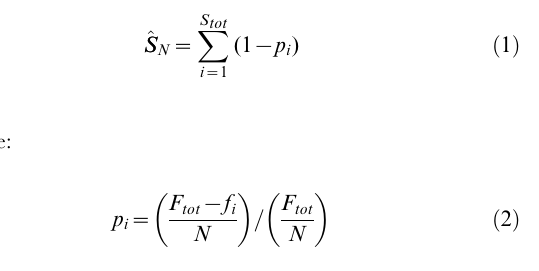
Table S1 Data matrix to generate Figure